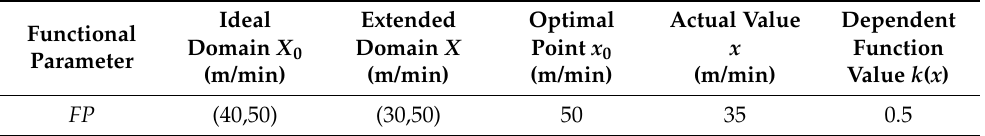
Table 3. Dependent function value